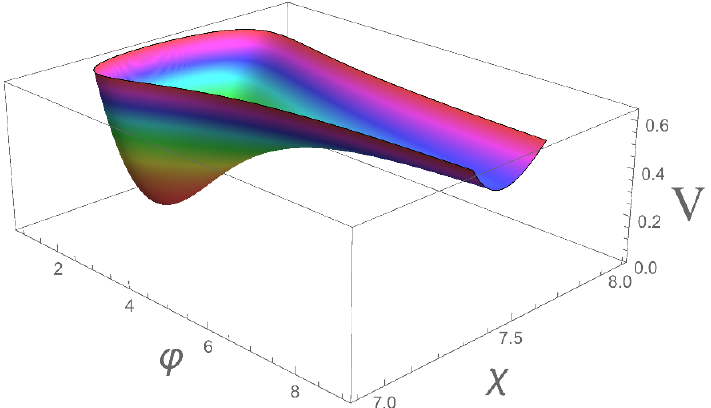
Figure 2 . The scalar potential V of the (cid:12)bre in(cid:13)ation with a particular set of parameters; (cid:31) is de(cid:12)ned by (cid:31) = log V